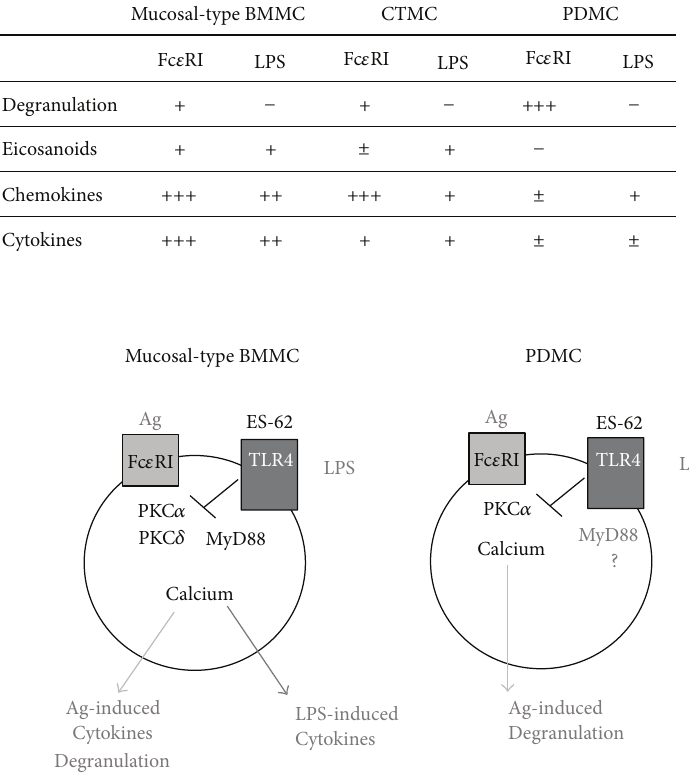
Figure 6: Model of differential desensitisation of mast cell subsets by ES-62. Mucosal-type BMMC, CTMC, and PDMC exhibit differential functional responses to antigen (Ag)-mediated cross-linking of Fc 𝜀 RI and stimulation with LPS as summarised. The signalling mechanisms underlying the coupling to these differential responses and their desensitisation by ES-62 have not been fully delineated but our working model is that the Fc 𝜀 RI-mediated degranulation observed in PDMC involves PKC 𝛼 and calcium mobilisation which are effectively targeted by ES-62. Although these cells express TLR4/MyD88, they are uncoupled from downstream functional LPS signalling by an as yet unknown mechanism. By contrast, mucosal-type BMMC exhibit both degranulation (via Ag/Fc 𝜀 RI) and cytokine (via Fc 𝜀 RI and LPS/TLR4) responses, requiring recruitment of additional signals such as PKC 𝛿 and MyD88 signalling which are both also targeted by